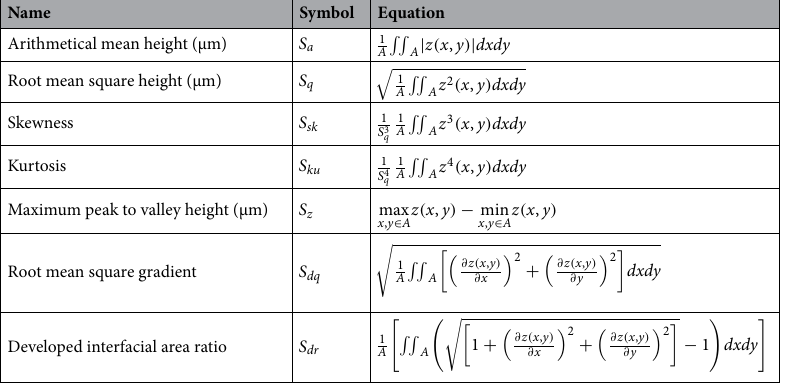
Table 2. Overview of implemented conventional surface roughness parameters for ordinate values z ( x , y ) within a definition area (A), equations as in ISO 25178.